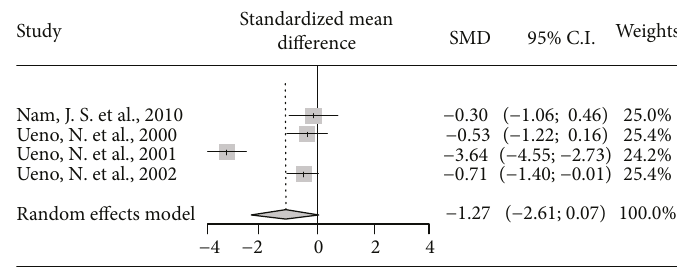
Figure 3: The results of the meta-analysis for